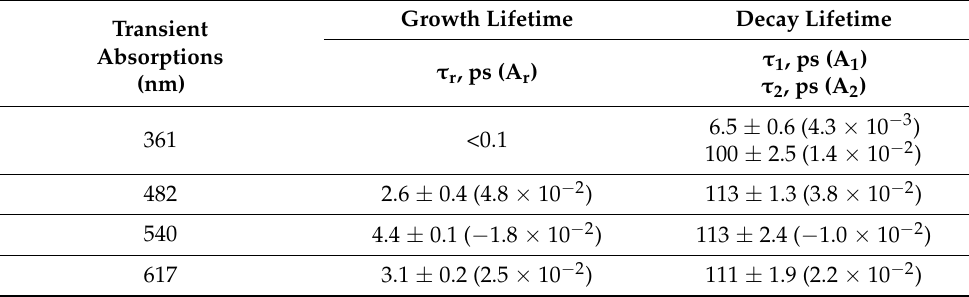
Table 1. Transient kinetics observed at various probe wavelengths of 1b.